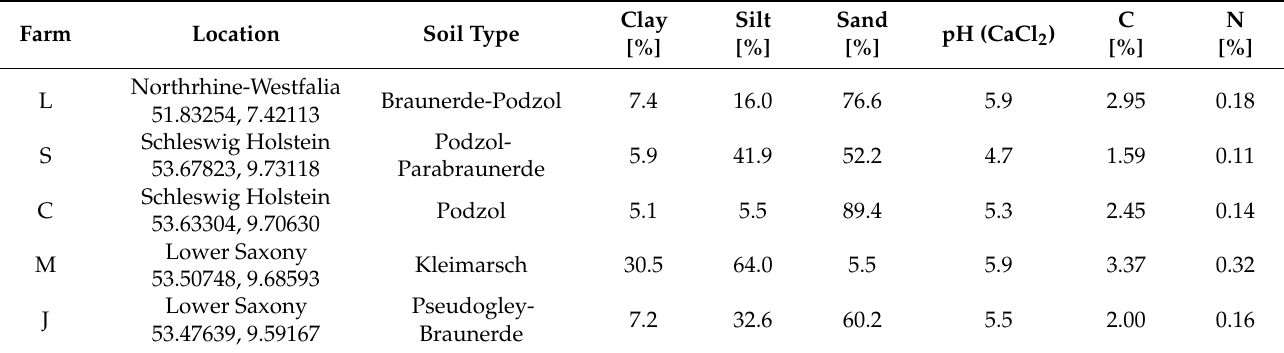
Table 2. Location and soil properties of experimental